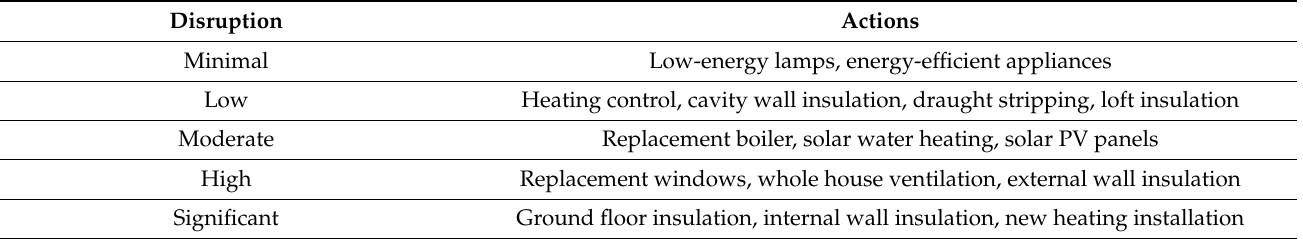
Table 2. Disruption levels